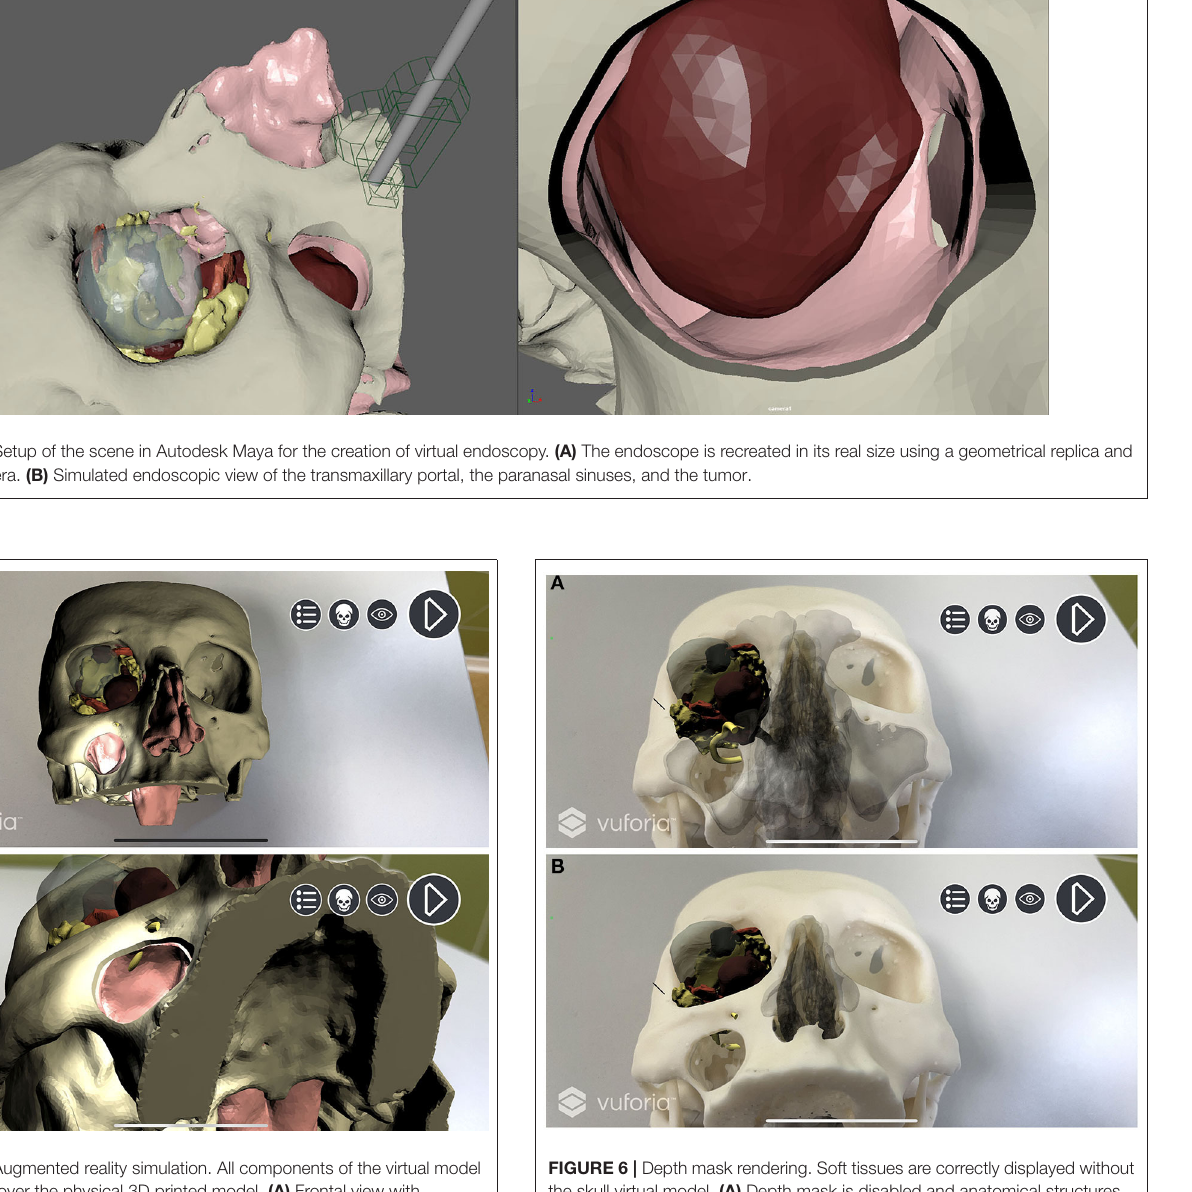
floor opening (the transorbital portal) and extracted from the anterior maxillary sinus opening (the transmaxillary portal).